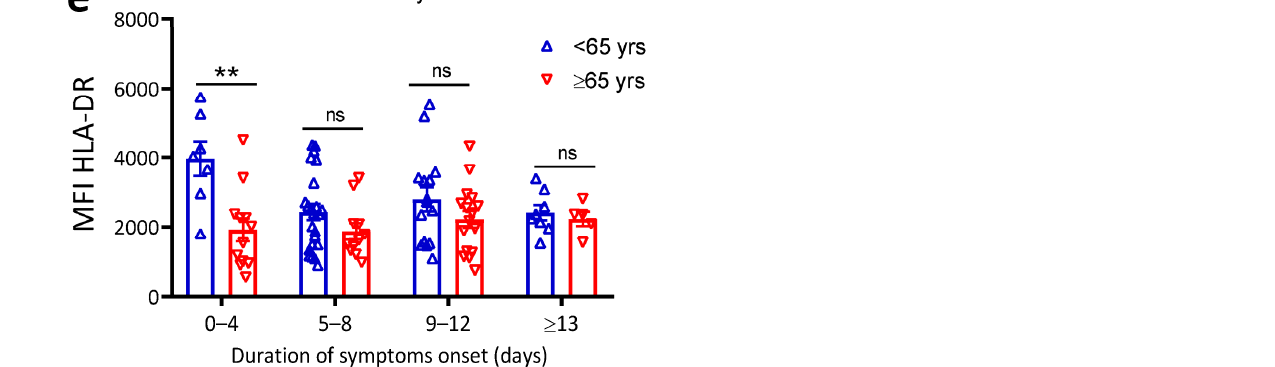
Figure 2. Elderly patients exhibited reduced monocyte activation and function. Flow cytometry analysis was performed on thawed PBMC from SARS-CoV-2 patients after an indicated timepoint of duration of symptom onset. Classical monocytes frequency and activation was analyzed. ( a ) Percentage of classical monocytes (% CD14 + CD33 + CD16 − monocytes), mean fluorescence intensity (MFI) of ( b ) CD169, ( c ) CD47, ( d ) CD86, and ( e ) HLA-DR ( n = 101). The data are shown as mean ± SEM. The statistical comparison of below 65 years (<65 years) vs. above 65 years ( ≥ 65 years) was performed using Student’s t -test (ns: not significant, * p <0.05, ** p < 0.01, *** p < 0.001).